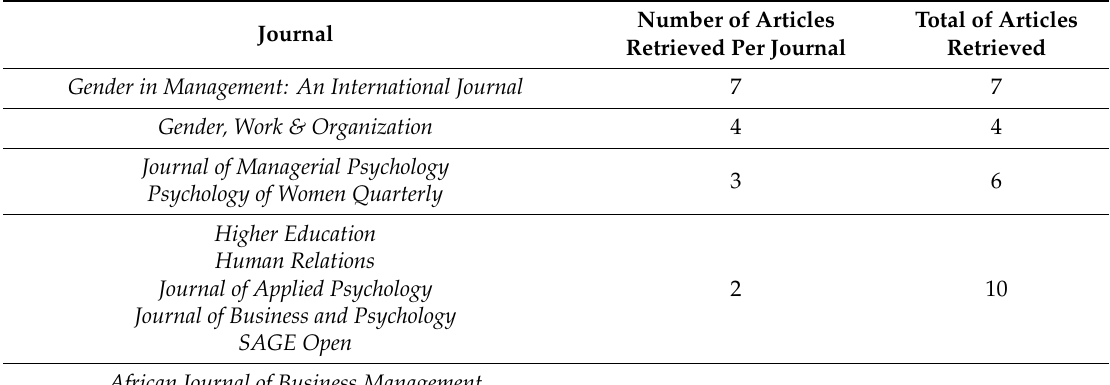
Table 4. Journal and number of articles in the content